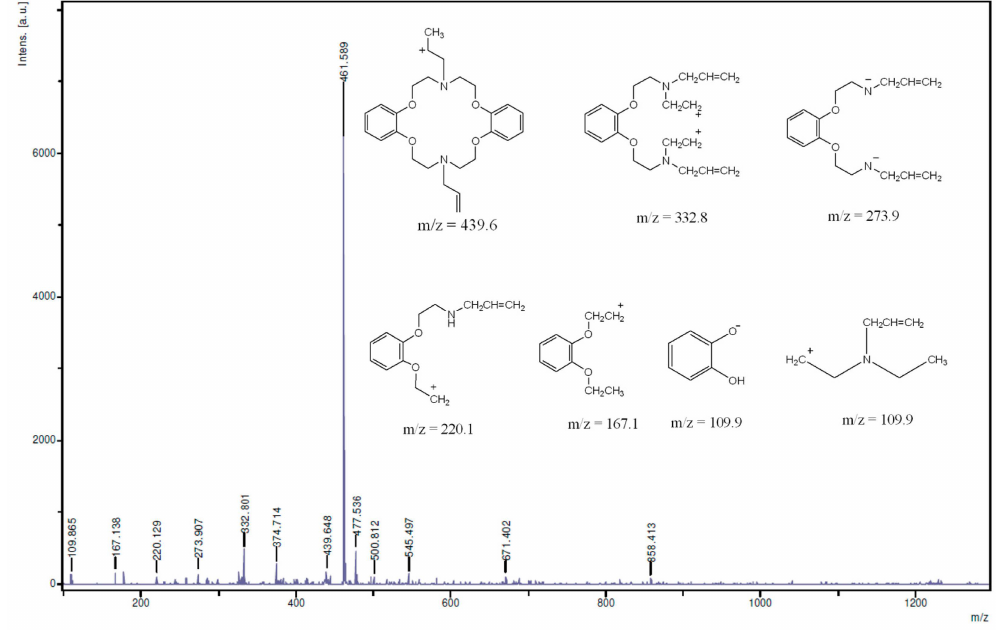
Figure 5. MS spectrum of the azacrown polyether macrocycle (solvent used; THF); (Inset are the important MS fragments of the